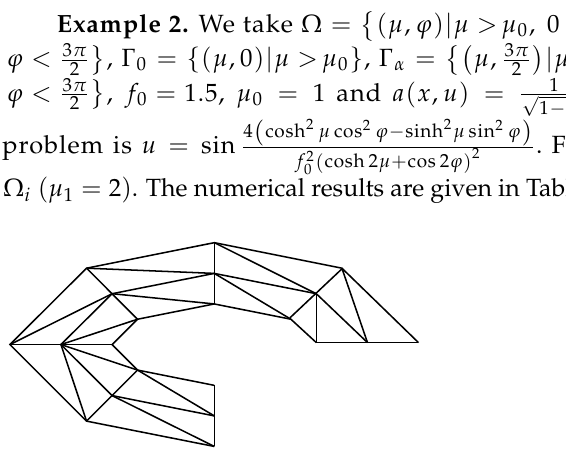
Ω Figure 6. Mesh ℎ of Ω (cid:3036) for Example 2. Figure 6. Mesh ℎ of Ω (cid:3036) for Example 2. Figure 6. Mesh h of i for Example Figure 6. Mesh ℎ of Ω (cid:3036) for Example 2.